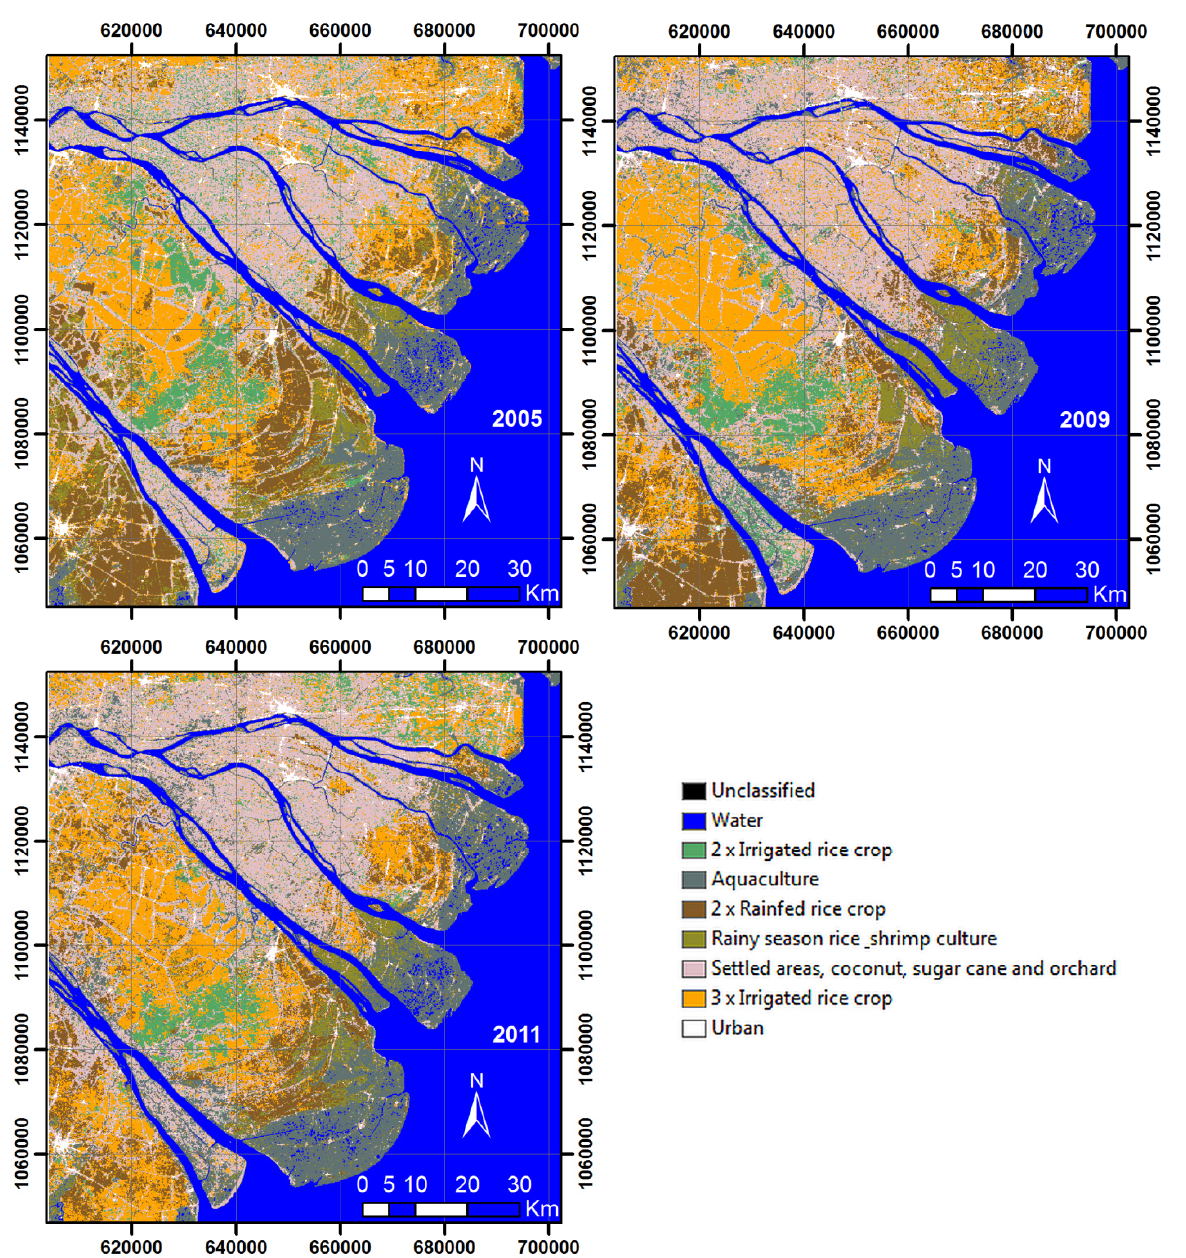
Figure 2. The land-use classifications from ENVISAT ASAR